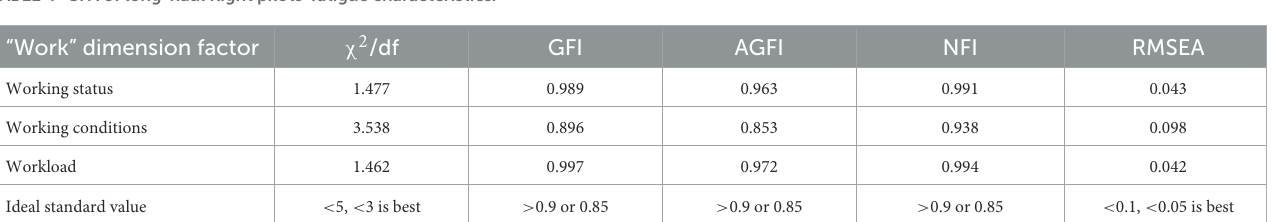
TABLE 4 CFA of long-haul flight pilots’ fatigue